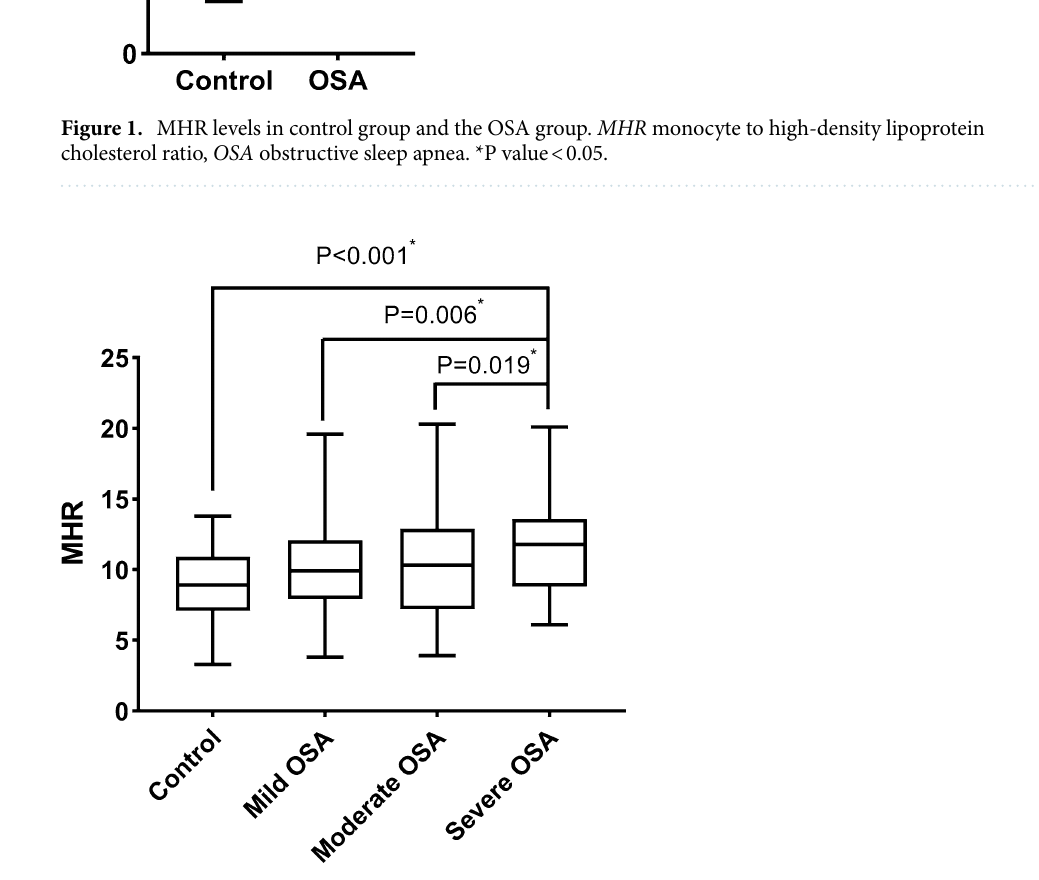
Figure 2. MHR levels in control group, the mild OSA group, the moderate group and the severe group. MHR monocyte to high-density lipoprotein cholesterol ratio, OSA obstructive sleep apnea. *P value < 0.05.